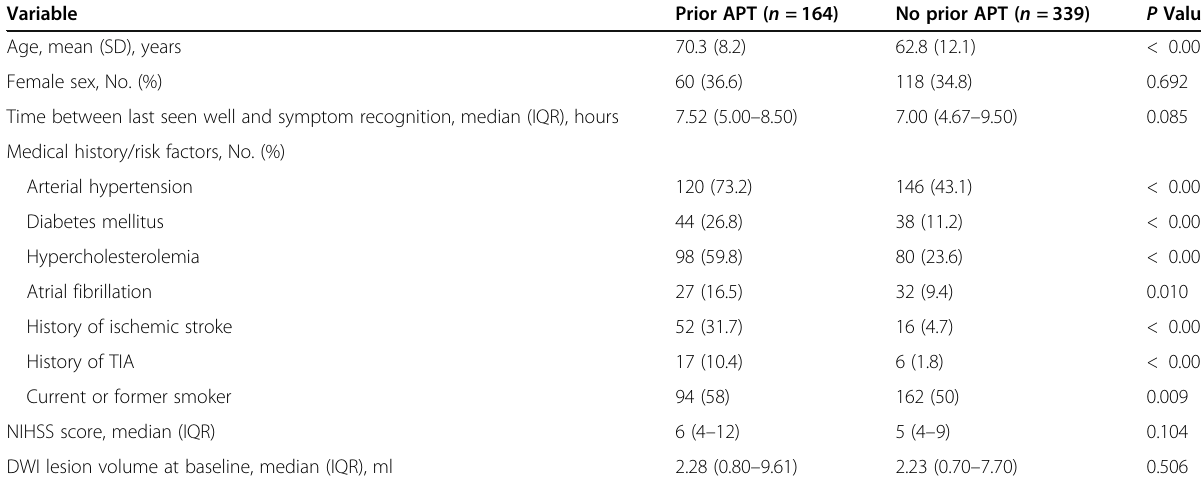
Table 1 Baseline characteristics of patients with ischemic stroke and unknown symptom onset